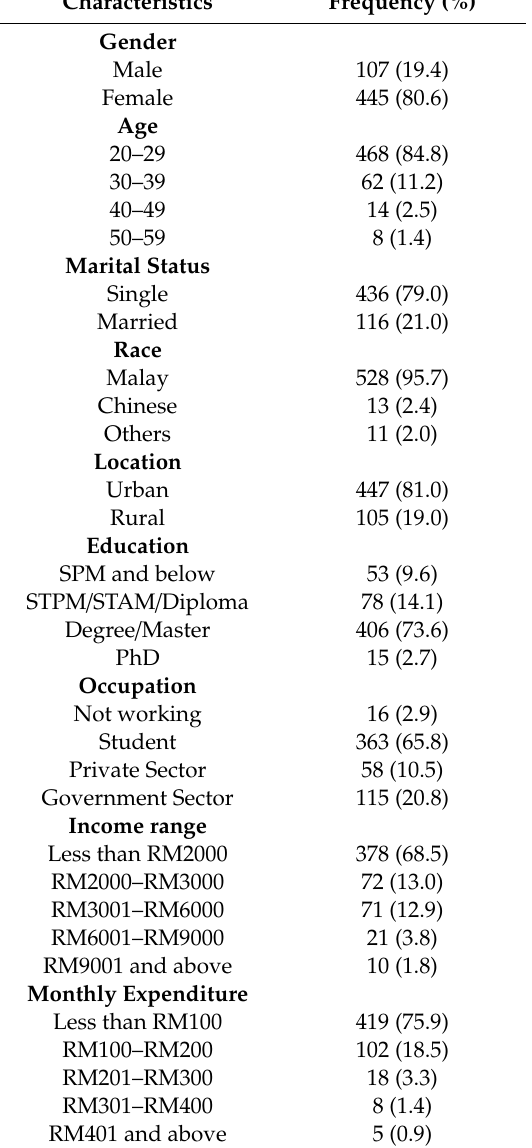
Table 1. Sociodemographic characteristics.